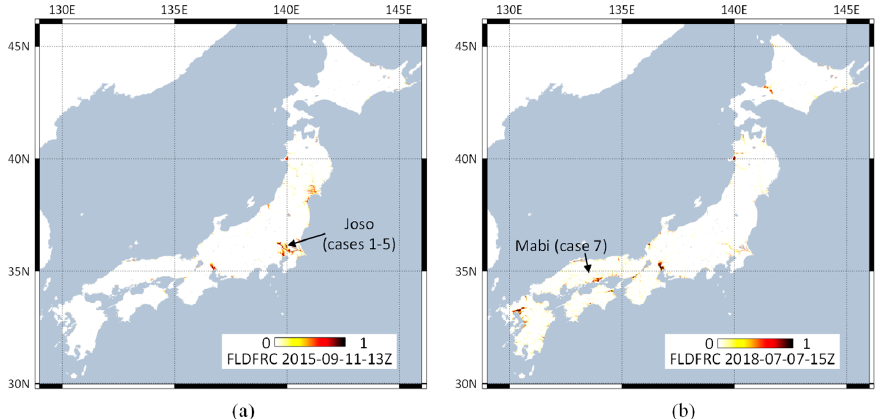
Figure 2. Flood fraction data provided by the Today’s Earth (TE) on ( a ) 11 September 2015 (Joso flood) and ( b ) 8 July 2018 (Mabi flood).